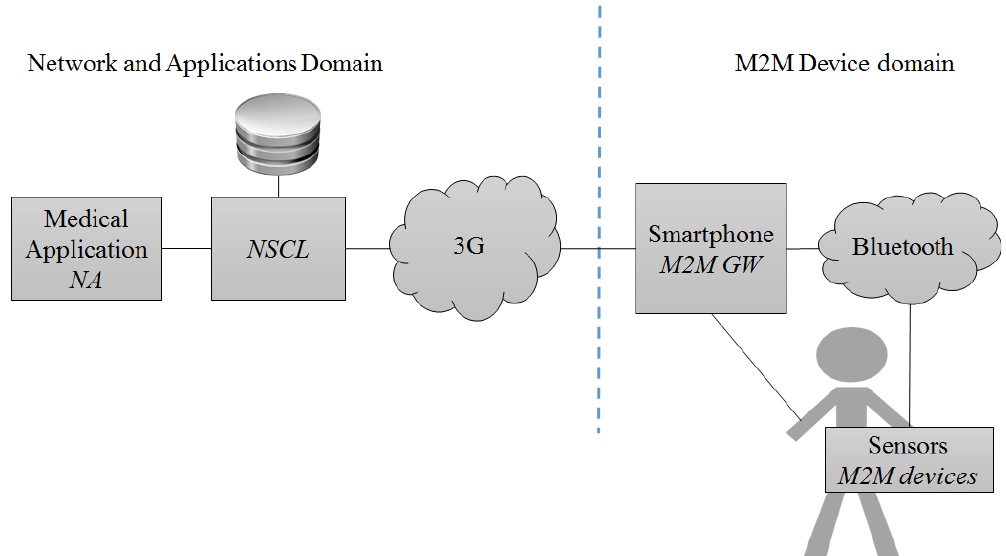
Figure 2. High-level view of the